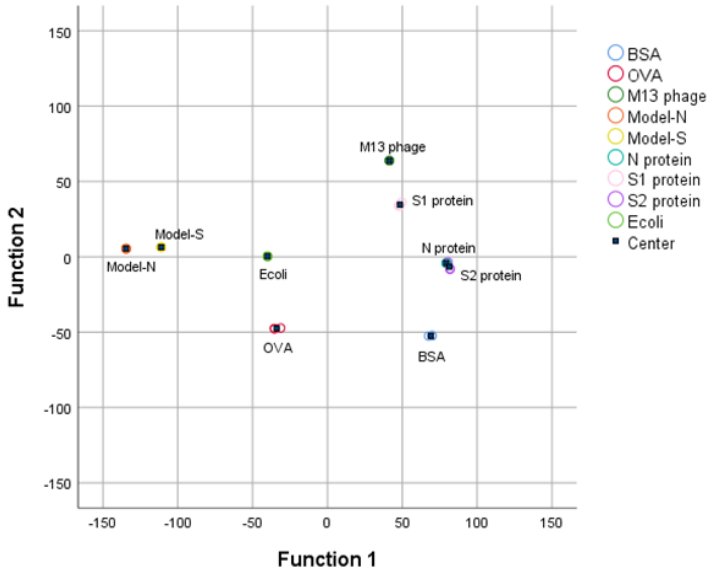
Table 3. Functions summarized from LDA and validation for 3DFS.